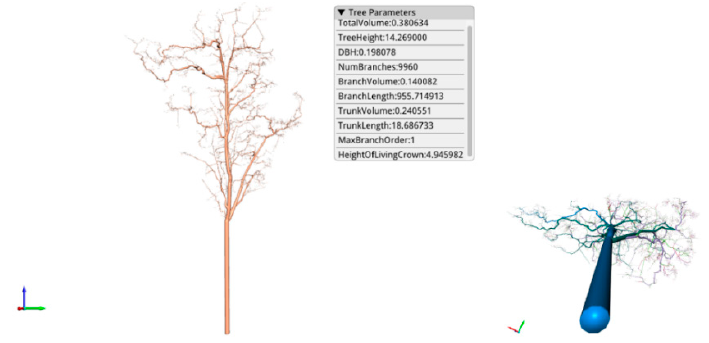
Figure 9. User interface for tree attributes.